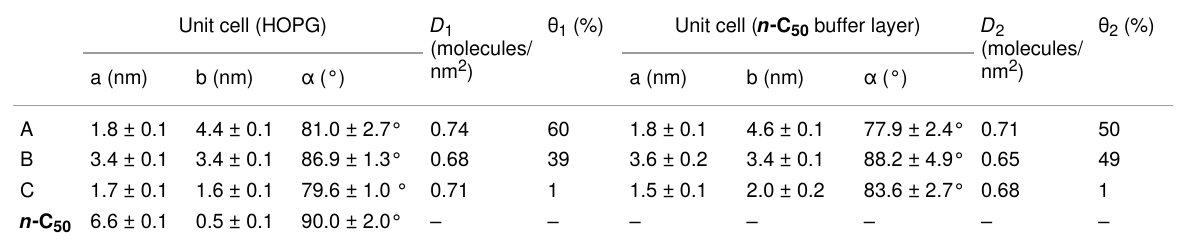
Table 1: Unit cell parameters for the benzoic acid polymorphs (A, B and C) observed in this study together with those of n -C 50 buffer layer. D 1 and D 2 are the molecular densities of the different polymorphs observed on HOPG and atop n -C 50 buffer layer, respectively. θ 1 and θ 2 are the percentage surface coverages of the respective polymorphs at [ BA-OC 14 ] = 9 × 10 − 5 M (on HOPG) and [ BA-OC 14 ] = 3.8 × 10 − 4 M ( n -C 50 buffer layer), respec- tively.